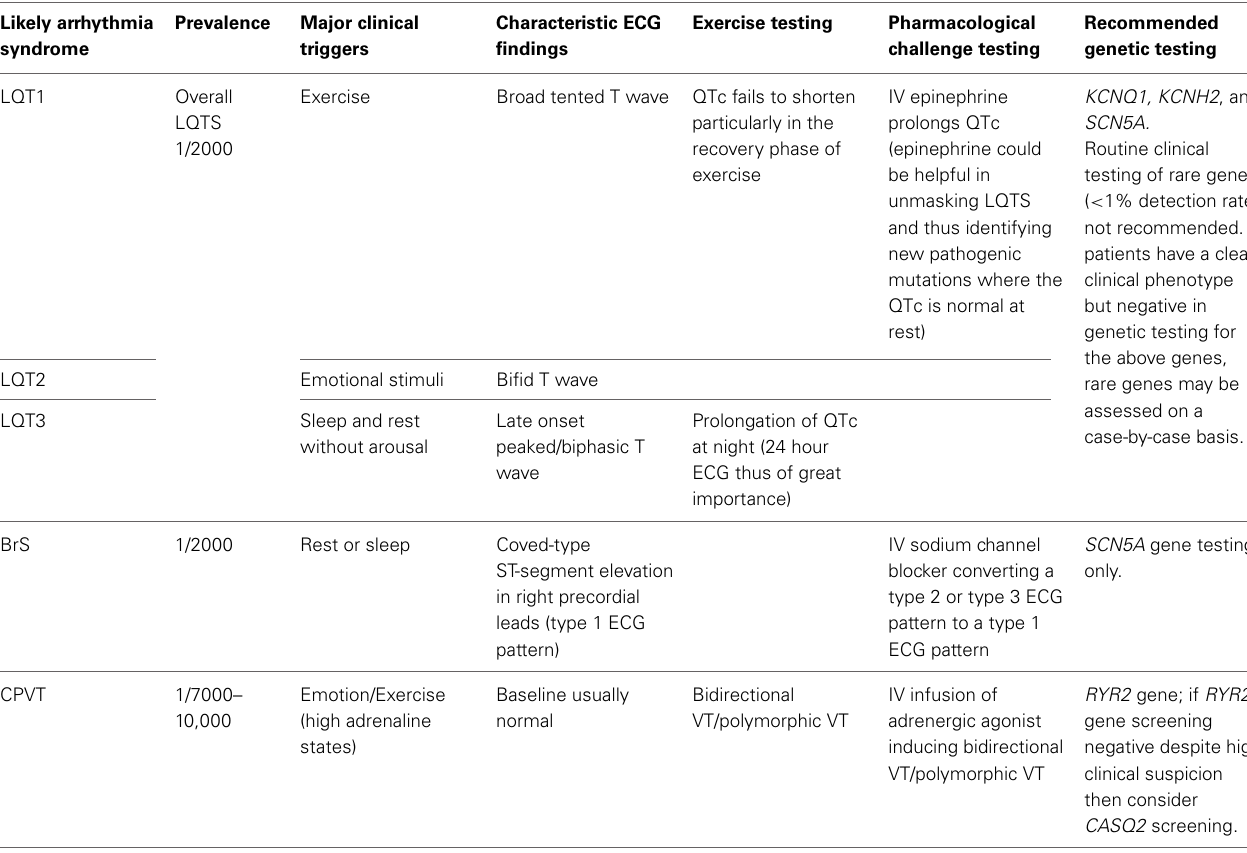
Table 2 | Outline of the current genetic testing recommendations for the principal ion channelopathies. Likely